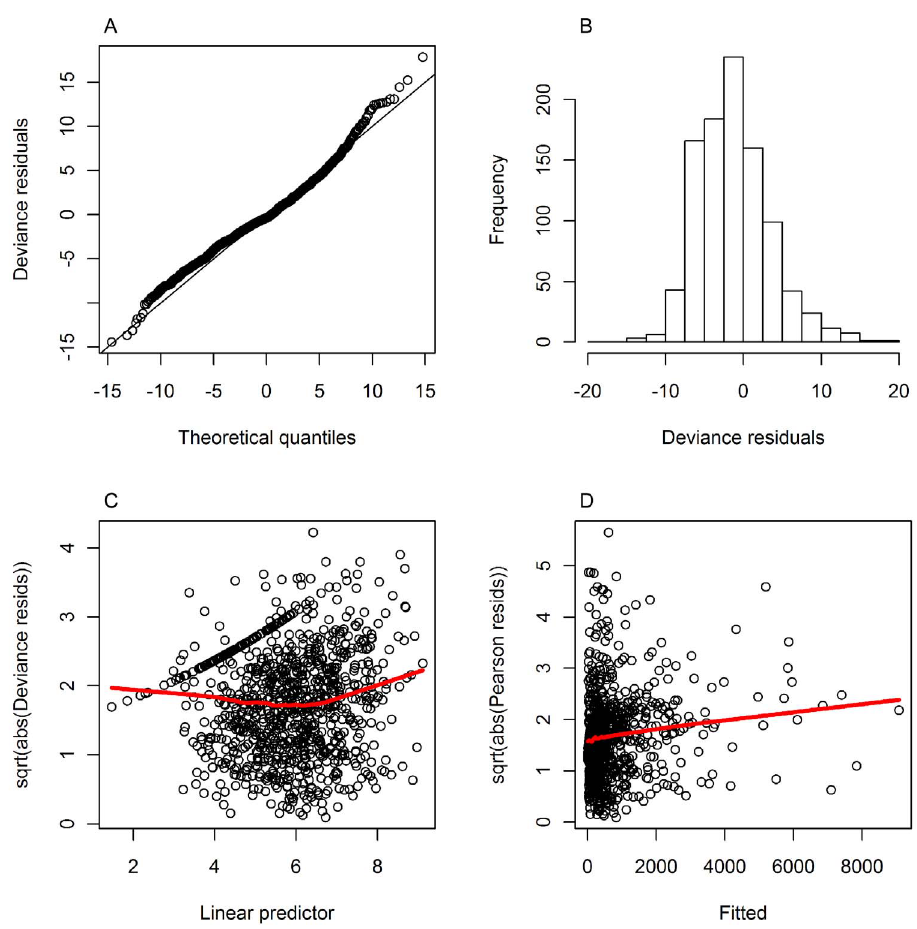
Fig. 2. Standard diagnostic plots for the GAM defined in Eqn. 1. Plots produced by mgcv-package in R: A) qq-plot, B) histogram of the deviance residuals, C) square root of absolute deviance residuals against the linear predictor, D) square root of the absolute Pearson residuals. The solid red lines in panels C and D are smooths fitted to the residuals to help highlight any strong trends that may be present.